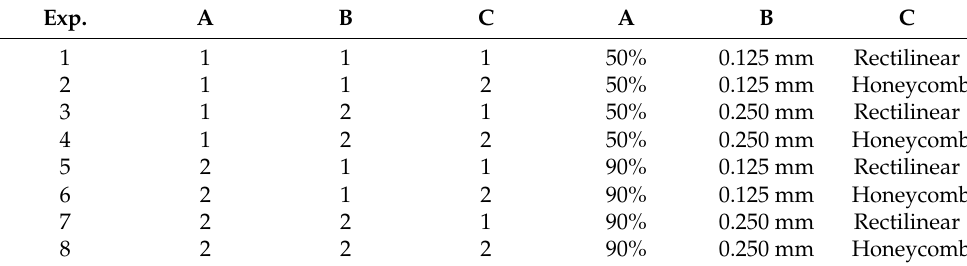
Table 2. Design of experiment for tensile strength measurement.